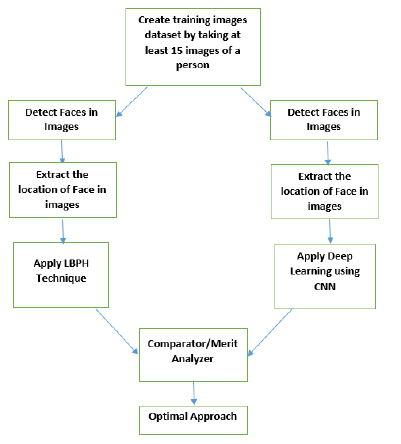
Figure 4 . Proposed Methodology